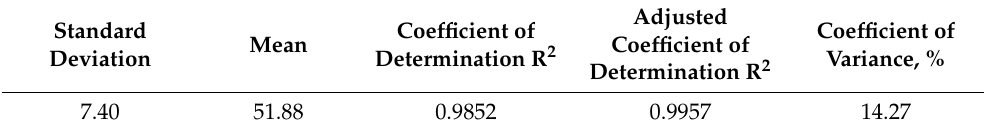
Table 6. Fit statistics for REML analysis of the maximum formable wall